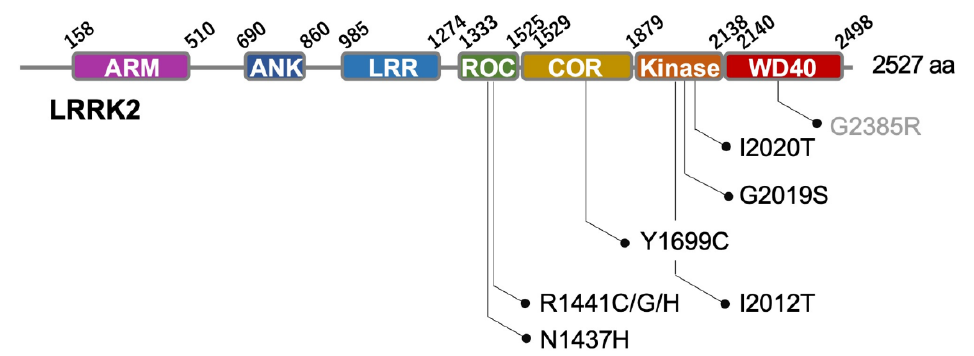
Figure 1. Domain structure of LRRK2. Sites of representative pathological mutations are indicated [7]. G2385R is considered a risk variant in Asian races [7]. LRRK2, leucine rich-repeat kinase 2; ARM, armadillo domain; ANK, ankyrin repeat domain; LRR, leucine-rich repeat domain; ROC, Ras of complex protein domain; COR, carboxyl-terminal of ROC domain; WD40, WD 40 domain; aa, amino acids.